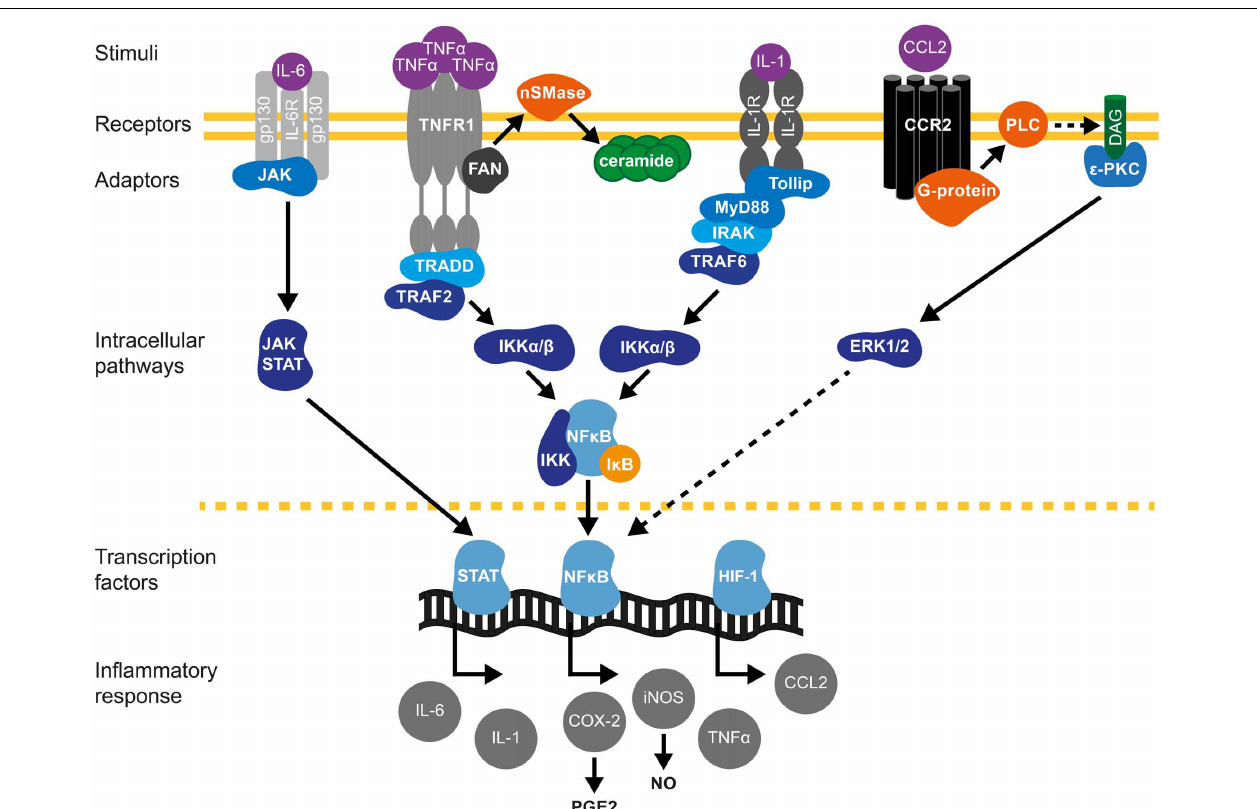
FIGURE 1 | Cytokine signaling pathways in brain preconditioning. Following preconditioning (PC), the increase in tumor necrosis factor (TNF)- α , interleukin (IL)-1 β and IL-6 and chemokine (C-C motif) ligand 2 (CCL2) leads to the activation of inflammatory cascades and induction of gene expression such as inducible nitric oxide synthase (iNOS) and cyclooxygenase (COX)-2, mediators of delayed PC. IL-6/IL-6R activates Janus kinase (JAK)-signal transducer and activator of transcription (STAT) pathway. Phosphorylation and nuclear translocation of STAT induces iNOS and COX-2 up-regulation (Dawn et al., 2004). TNF- α activates TNF receptor 1(TNFR1)/Tumor necrosis factor receptor type 1-associated DEATH domain protein (TRADD)/TNF- α receptor–associated factor 2 (TRAF2) pathway (Hallenbeck, 2002; Pradillo et al., 2005). Furthermore, TNF- α activation promotes ceramide synthesis that also mediates TNF α -preconditioning (Liu et al., 2000; Ginis et al., 2002). The neutral sphingomyelinase domain (NSD) of TNFR1 recruits factor associated